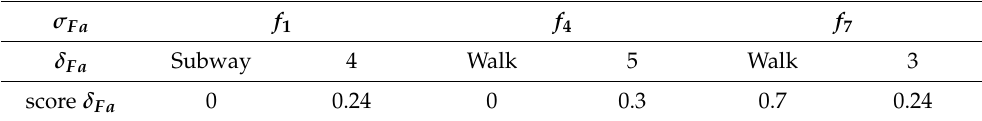
Table 4. Scores for the sub-sequence σ Fa .